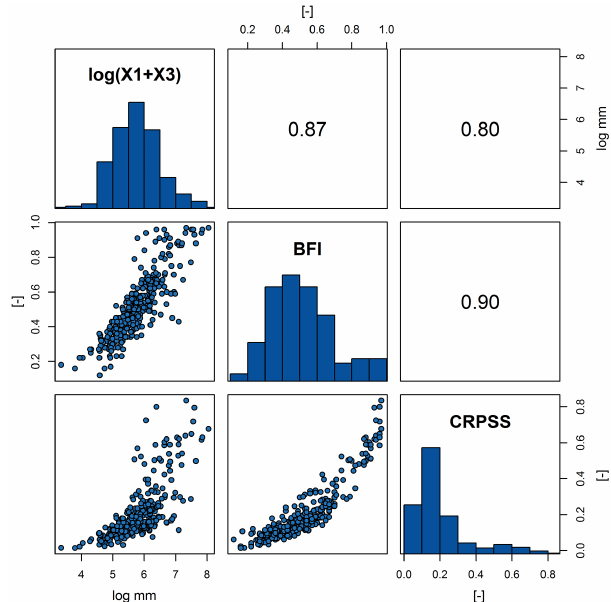
Figure 8. Scatterplot matrix between catchment storage capacity (X1 soil moisture store capacity [mm] + X3 groundwater store ca- pacity [mm]), BFI, and ESP skill (CRPSS) with n = 314 using the non-parametric Spearman’s rank correlation coefficient ρ . Skill is the 1-month CRPSS skill score magnitude averaged across all 12 initialization months. Catchment storage capacity (X1 + X3) was re-expressed by taking the natural log, as raw values are heavily positively